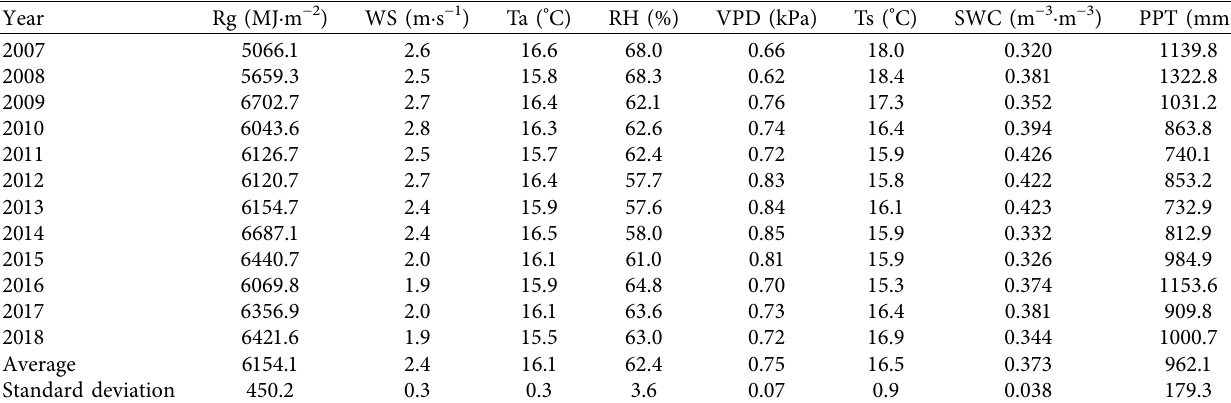
Figure 4: Box chart of monthly averaged air temperature (a) and precipitation (b) from 1951 to 2018. Te circle, square, and fve-pointed star represent the mean, minimum, and maximum values, respectively. Te horizontal line on the box represents the median and the box represents the 25–75th percentiles. Te whisker represents the 5–95th Table 3: Annual total global solar radiation (Rg), annual averaged wind speed (WS) at 10m height, air temperature (Ta), and relative humidity (RH) at 4m height, vapor pressure defcit (VPD), soil temperature (Ts), and soil water content (SWC) at 4cm depth, and annual total precipitation (PPT) at the Dali site from 2007 to 2018.